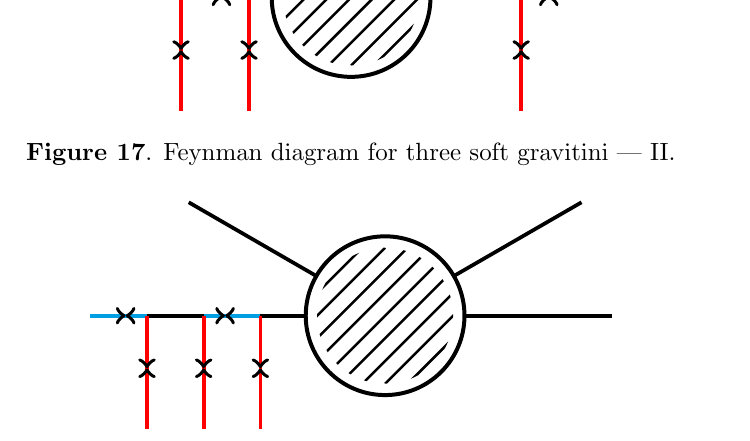
Figure 18 . Feynman diagram for three soft gravitini |